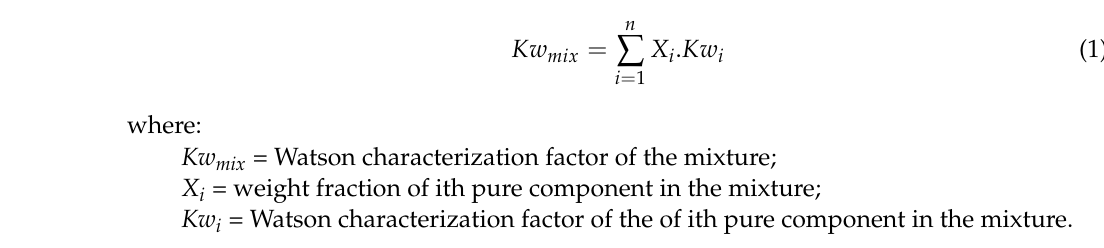
Figure 2. Dependence of the consonanse of mixed feed Kw and Kw of H-Oil ® liquid products on the average boiling point of the liquid products.